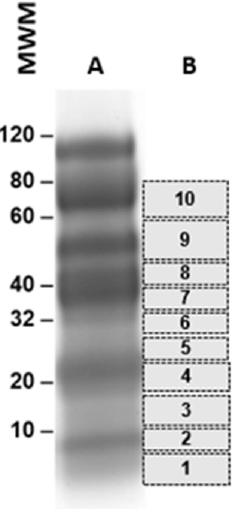
Figure 1. Illustration of gel bands that were cut from PAGE for subsequent mass spectroscopy analysis. The patient urine samples (3 mL) had a concentration of ~300 µ L and were subjected to PAGE, followed by Coomassie blue staining ( A ). Ten bands were cut from the gel ( B ) and subjected to mass spectroscopy for the identification of P. vivax peptide sequences.